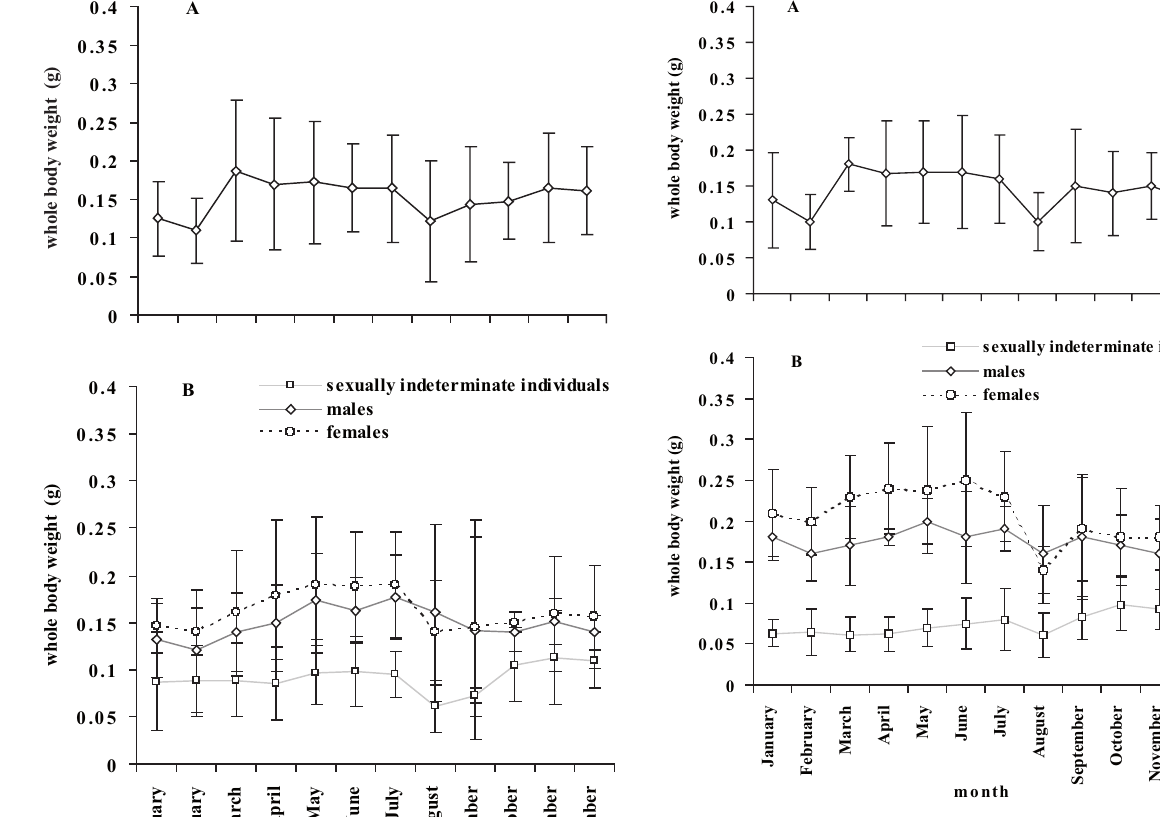
Fig . 7. – Monthly variation between January and December 2005 of mean individual whole body weight at Figuier. A: for all individu- als, B: for the sexually indeterminate and differentiated individuals. Each data point represents mean ± standard